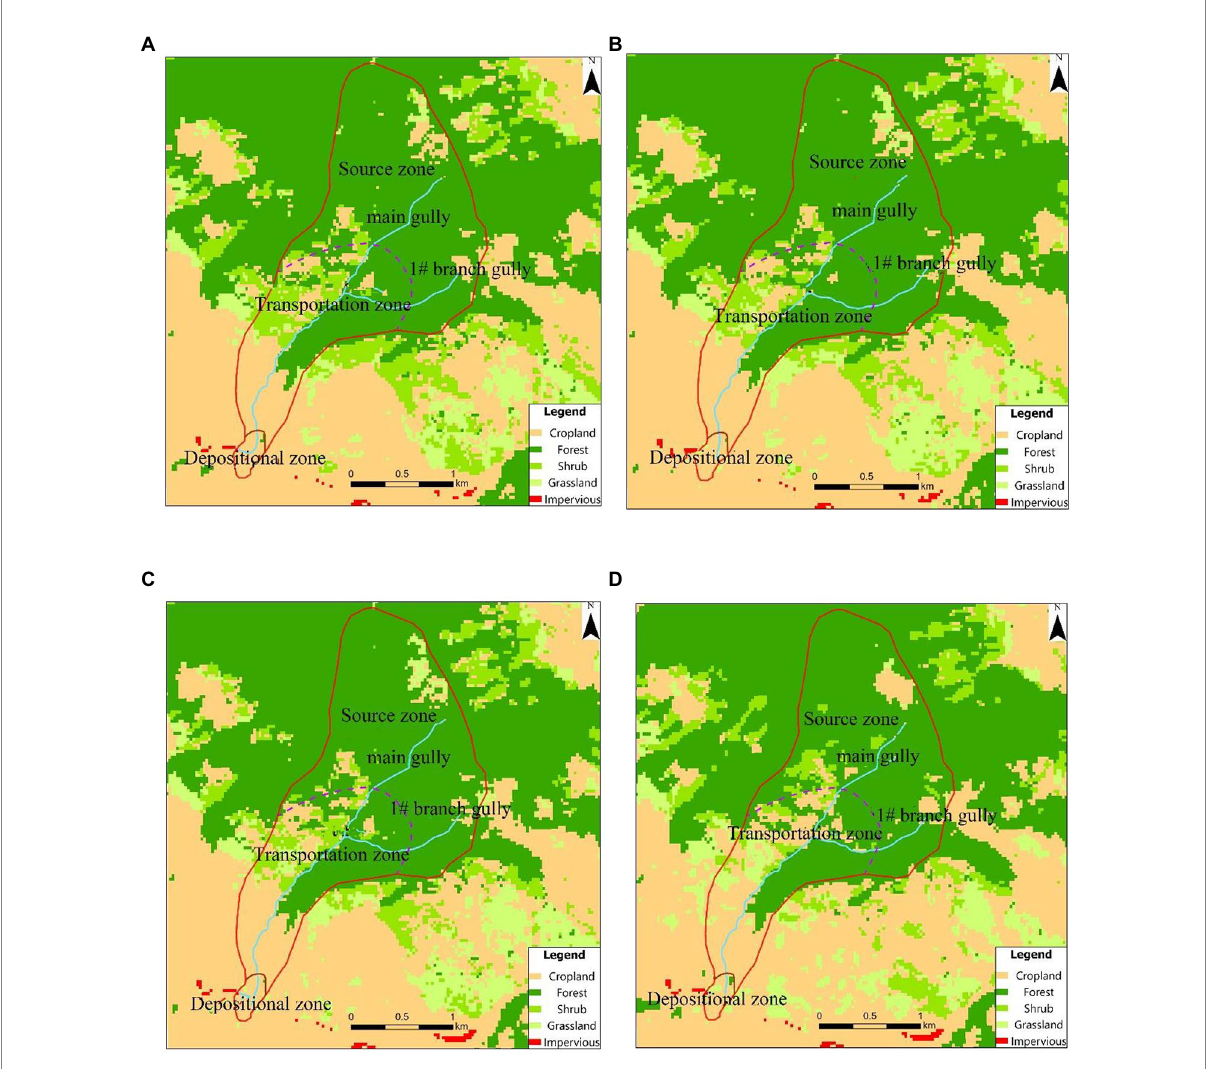
FIGURE 11 Land use type of Legugou Watershed in different years. (A) Image of year 2007. (B) Image of year 2009. (C) Image of year 2012. (D) Image of year 2019.